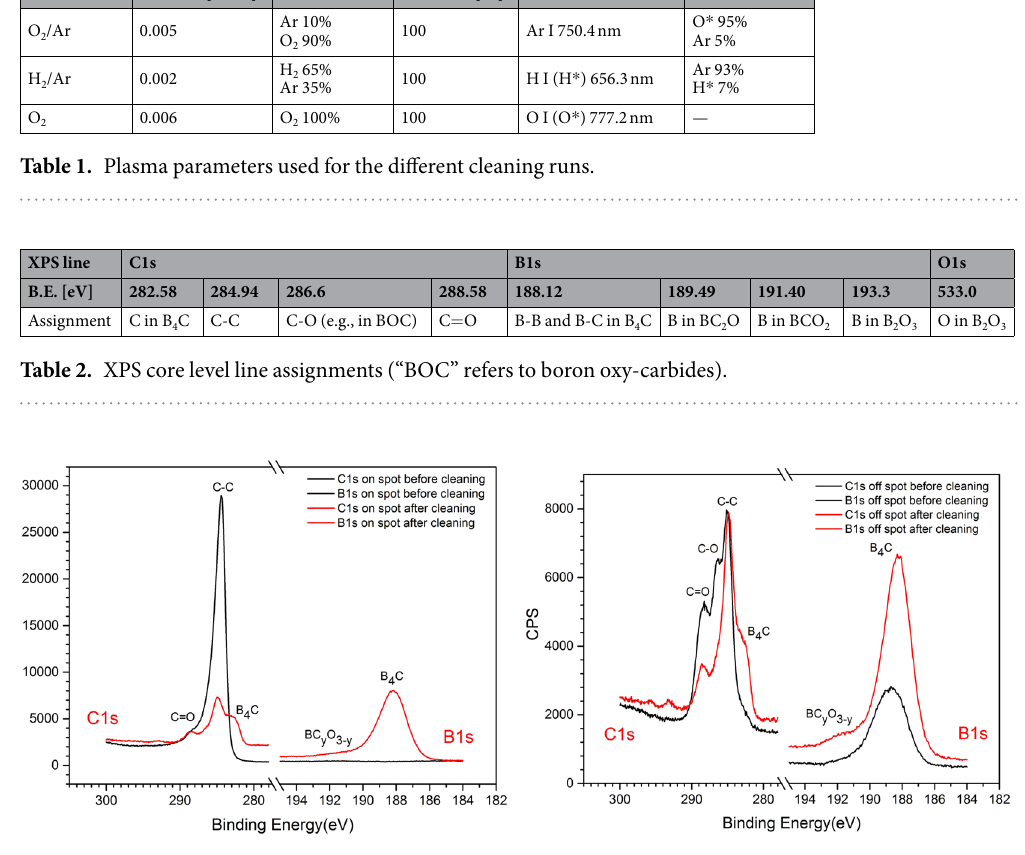
Figure 1. High-resolution C1s and B1s XPS spectra of the B 4 C-coated test wafer before (black solid lines) and after O 2 /Ar RF plasma cleaning (red solid lines). Left panel: XPS data taken on the amorphous carbon contamination spot. Right panel: XPS data taken off the amorphous carbon contamination spot on the bare B 4 C coating.